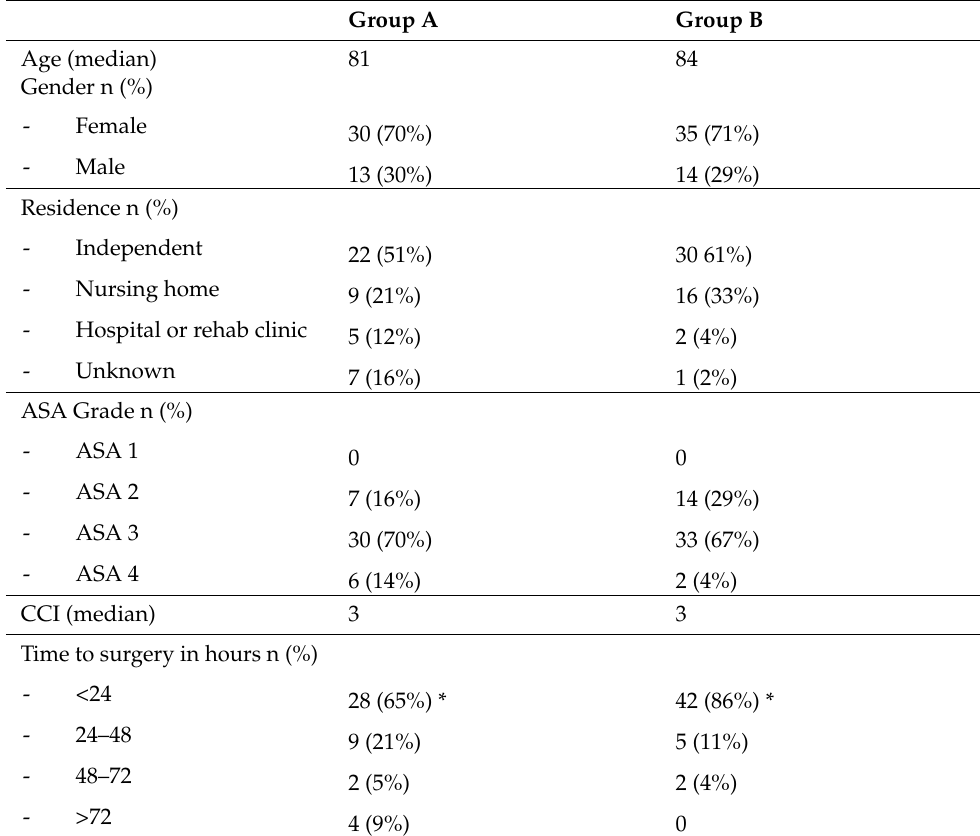
Table 2. Patients characteristics, * p < 0.05